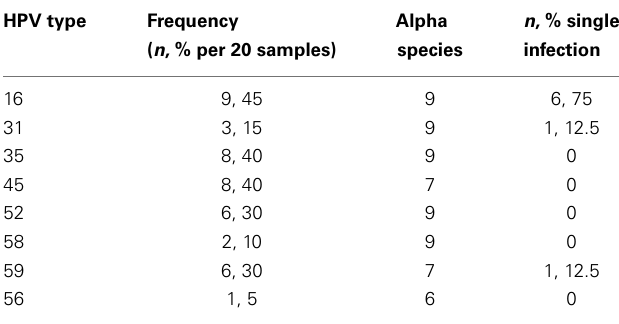
Table 4 |Types by species and single infection .